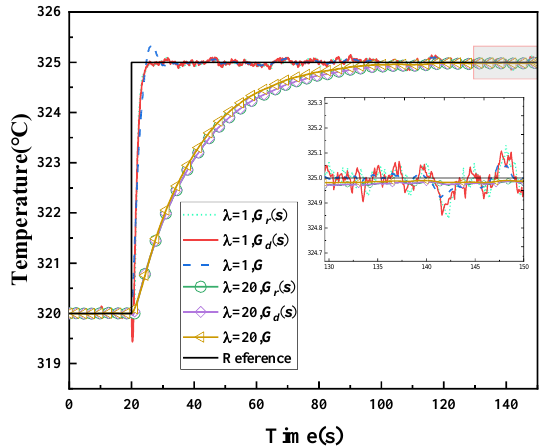
Figure 13. Influence of noise on different controller parameters.